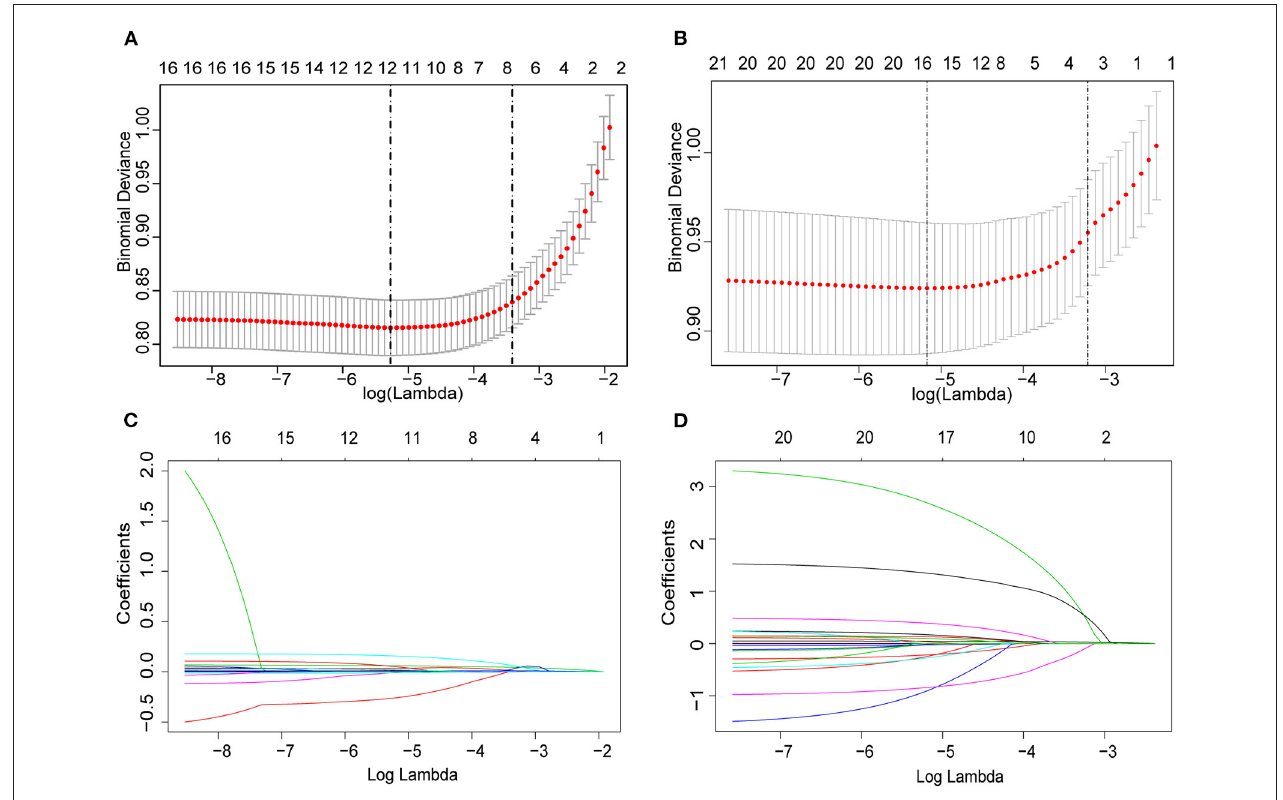
FIGURE 2 | Predictor selection using the least absolute shrinkage and selection operator (LASSO) logistic regression model. (A,B) Identification of the optimal penalization coefficient lambda ( λ ) in the LASSO model. The dotted vertical line was plotted at the value selected using 10-fold cross-validation, for which the optimal λ resulted in 10 non-zero coefficients. (C,D) LASSO coefficient profiles of the 22 clinical features and 33 potential blood biochemical predictors. A coefficient profile plot was produced against the log ( λ )